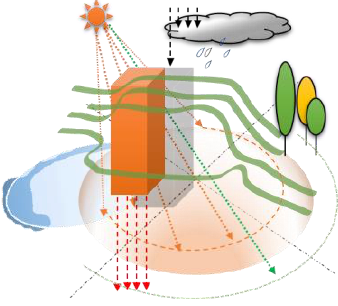
Fig. 4. Passive bioclimatic architecture design